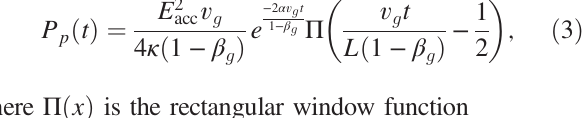
FIG. 9. Isolation of the IOM output from the high power TM 01 accelerating mode for the TE 11 IOM coupler alone and for the transition section. Fig. 7. The extracted power is 73.4% at 190 GHz with a 3-dB bandwidth of approximately 16 GHz.